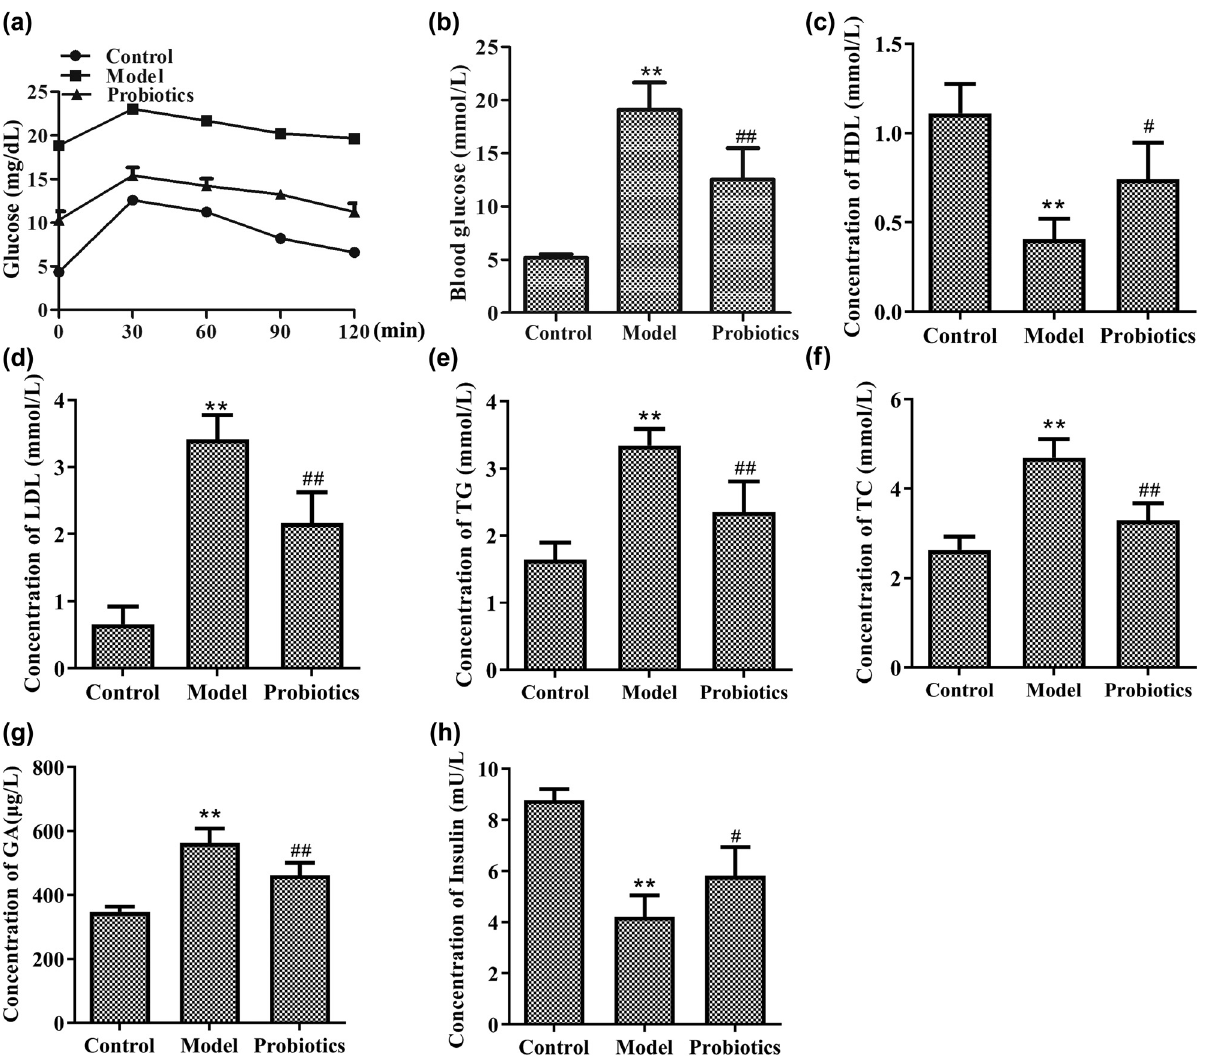
Figure 1: AUC and several blood biochemical indexes were analyzed after the administration of Probio - M8 in T2DM mice. ( a ) The AUC in the control, model, and probiotic groups was analyzed. ( b and c ) The increase level of glucose and decreased level of HDL in T2DM mice were suppressed by the addition of Probio - M8. ( d – f ) The increased levels of LDL, TG, and TC in T2DM mice were eliminated by the addition of Probio - M8. ( g ) The increase level of GA in T2DM mice was eliminated by the addition of Probio - M8. ( h ) The reduced level of insulin in T2DM mice was eliminated by the addition of Probio - M8. ** P < 0.01 vs control, ## P < 0.01 vs